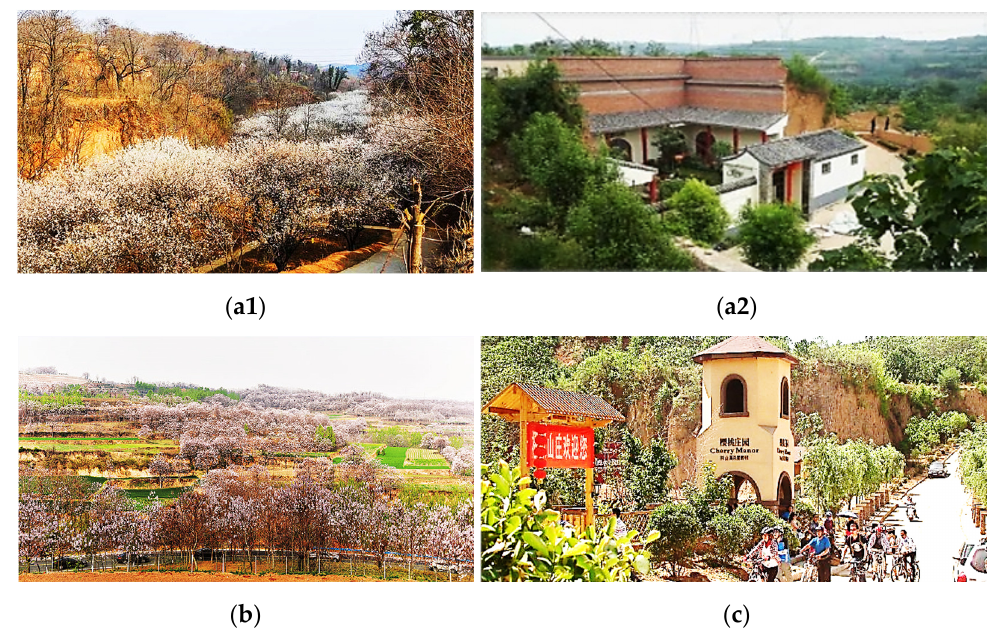
Figure 5. Representative landscape of each subzone of the TAL Core Zone: ( a1 ) TRL (ancient cherry orchards); ( a2 ) TRL (traditional settlement); ( b ) ANEL; ( c ) MVL.